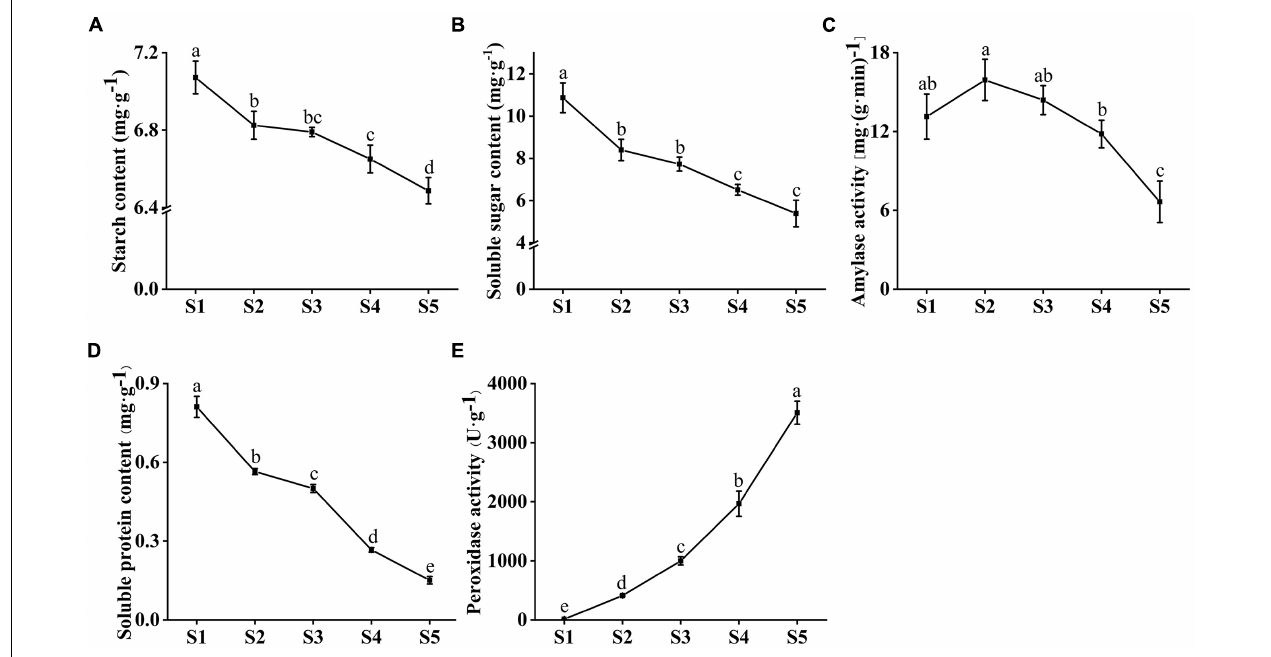
FIGURE 3 | Changes in physiological indexes of Carex rigescens seeds at five different germination stages under variable temperature. (A) Starch content. (B) Soluble sugar content. (C) Amylase activity. (D) Soluble protein content. (E) Peroxidase activity. Different small letters indicate that physiological indexes at different seed germination stages significantly different ( P < 0.05) based on one-way ANOVA.